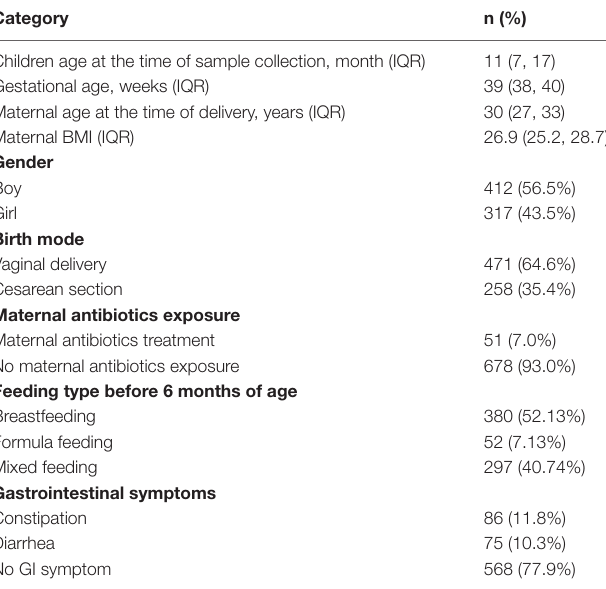
TABLE 1 | Characteristics of the study